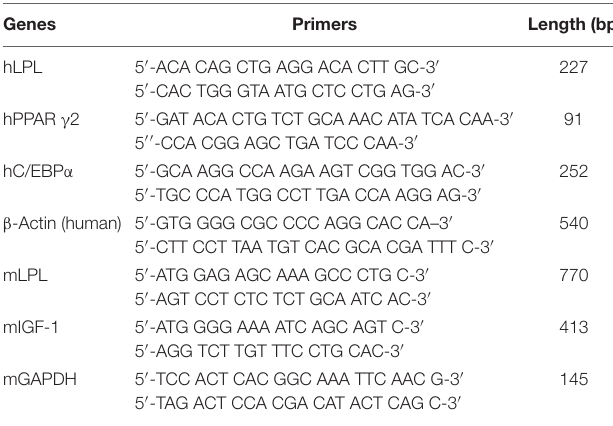
TABLE 1 | Primers used in